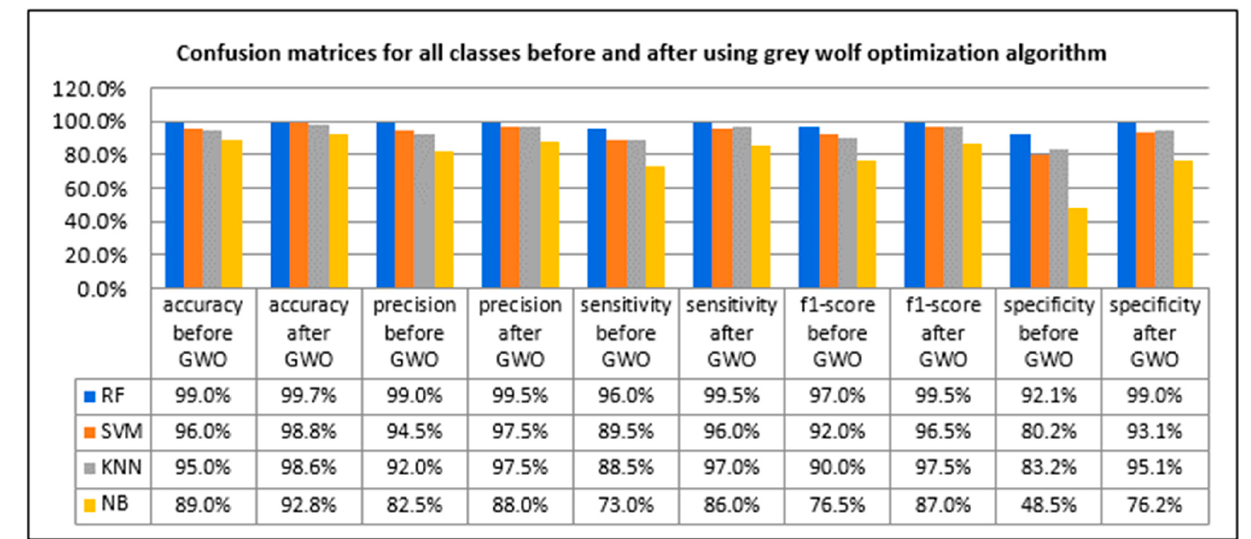
( d ) Figure 13. Confusion matrices analyses of the proposed model for ( a ) random forest, ( b ) support vector machine, ( c ) k ‐ nearest neighbor and ( d ) naïve Bayes classifiers after using grey wolf optimi ‐